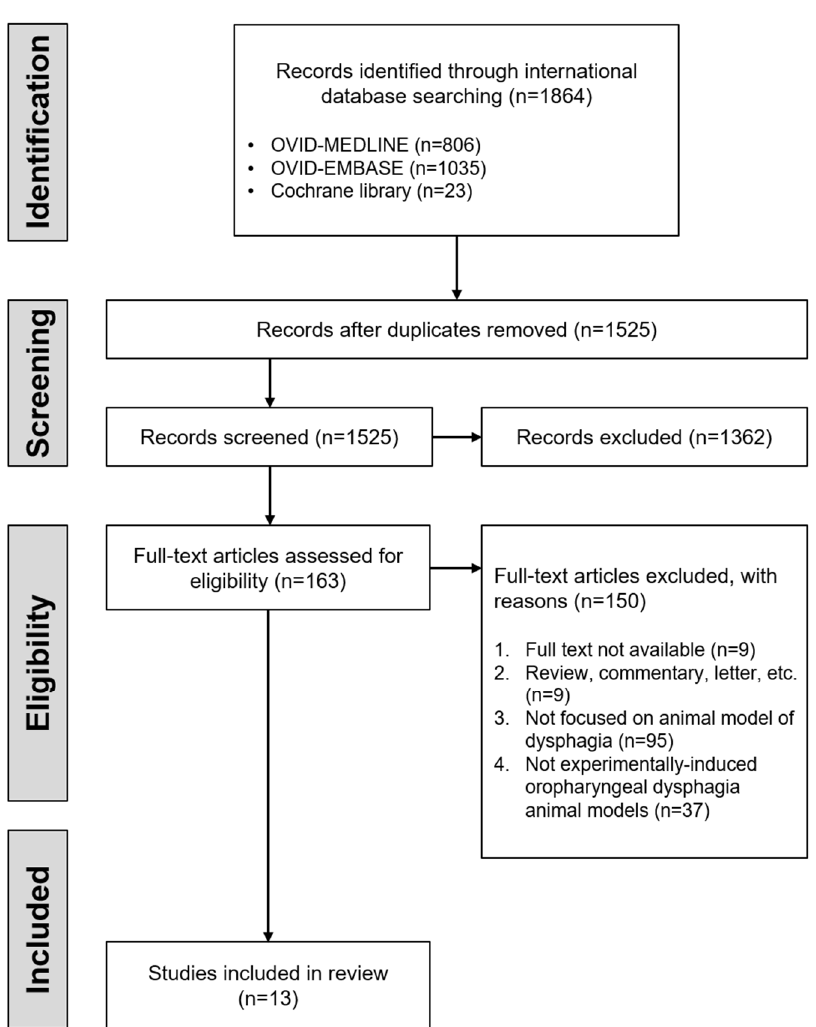
Figure 1. Flow diagram for literature searching and selection.